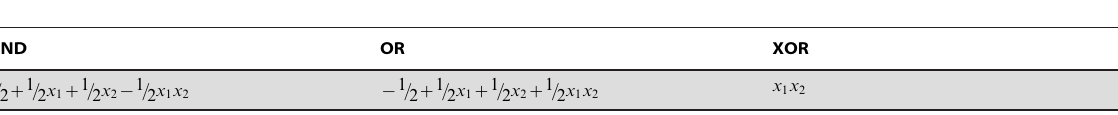
Table 2. Polynomial representation (Eq. (2) ).